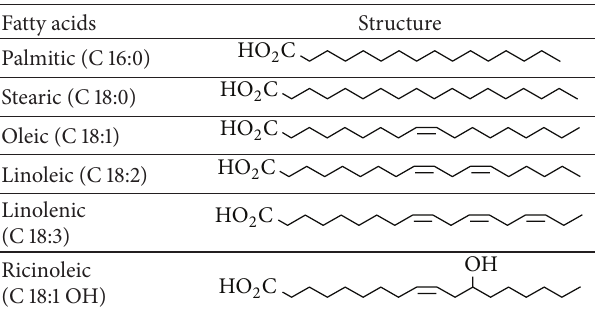
Table 1: Six common fatty acids’ composition in vegetable oils. Fatty acids